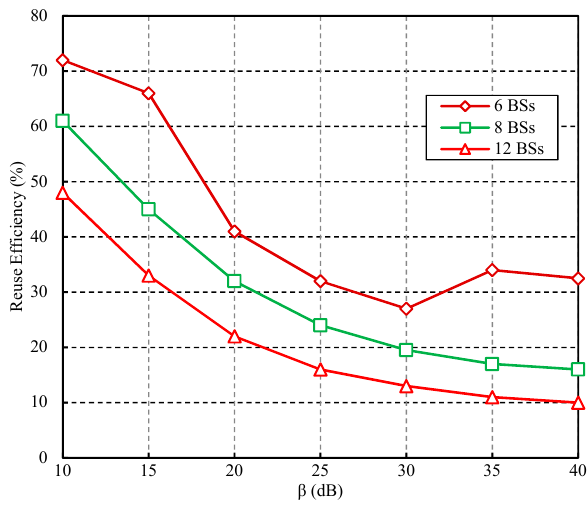
Figure 3. SIR impact on reuse efficiency.